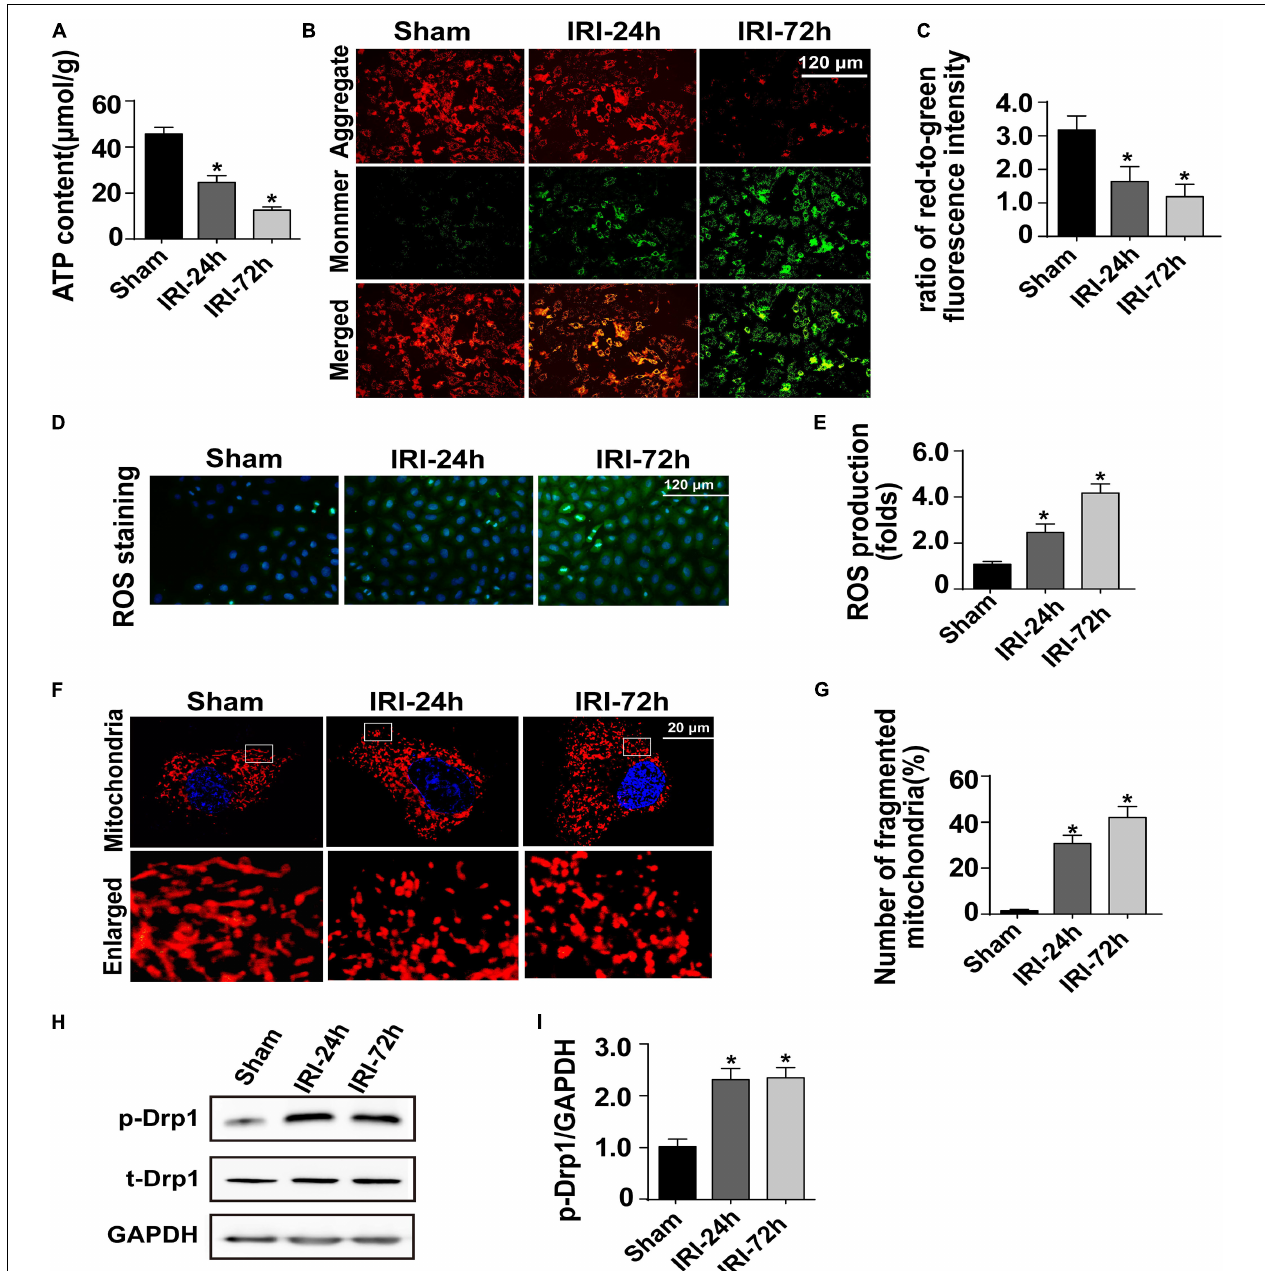
FIGURE 2 | Acute kidney injury (AKI) induces damage to cardiomyocyte mitochondria. (A) ATP production was measured through Enhanced ATP Assay Kit. (B,C) Cardiomyocytes were isolated from mice after AKI. Then, mitochondrial membrane potential was determined through JC-1 probe in primary cardiomyocytes. The ratio of red-to-green fluorescence intensity was used to evaluate mitochondrial membrane potential. (D,E) In cardiomyocytes, DCFH-DA was used to observe the levels of intracellular reactive oxygen species. (F,G) Immunofluorescence of the mitochondria. The number of fragmented mitochondria in cardiomyocytes was recorded. (H,I) Western blots were used to analyze the expression of phosphorylated Drp1 (p-Drp1). The relative expression of p-Drp1 was evaluated in cardiomyocytes. * p < 0.05 vs. sham group.